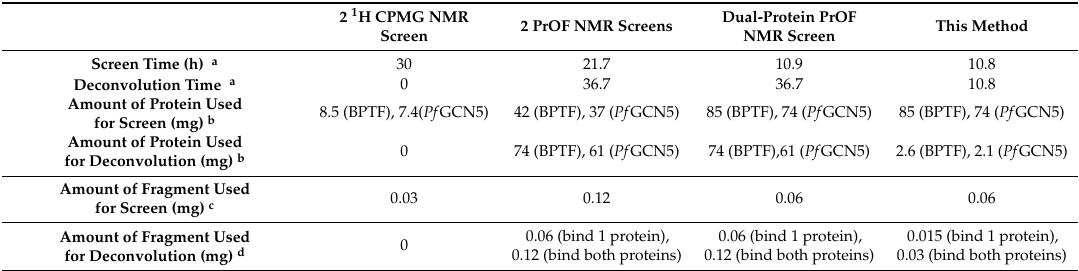
Table 3. Comparison of the resources used in di ff erent screening methods based on the results of this screen.